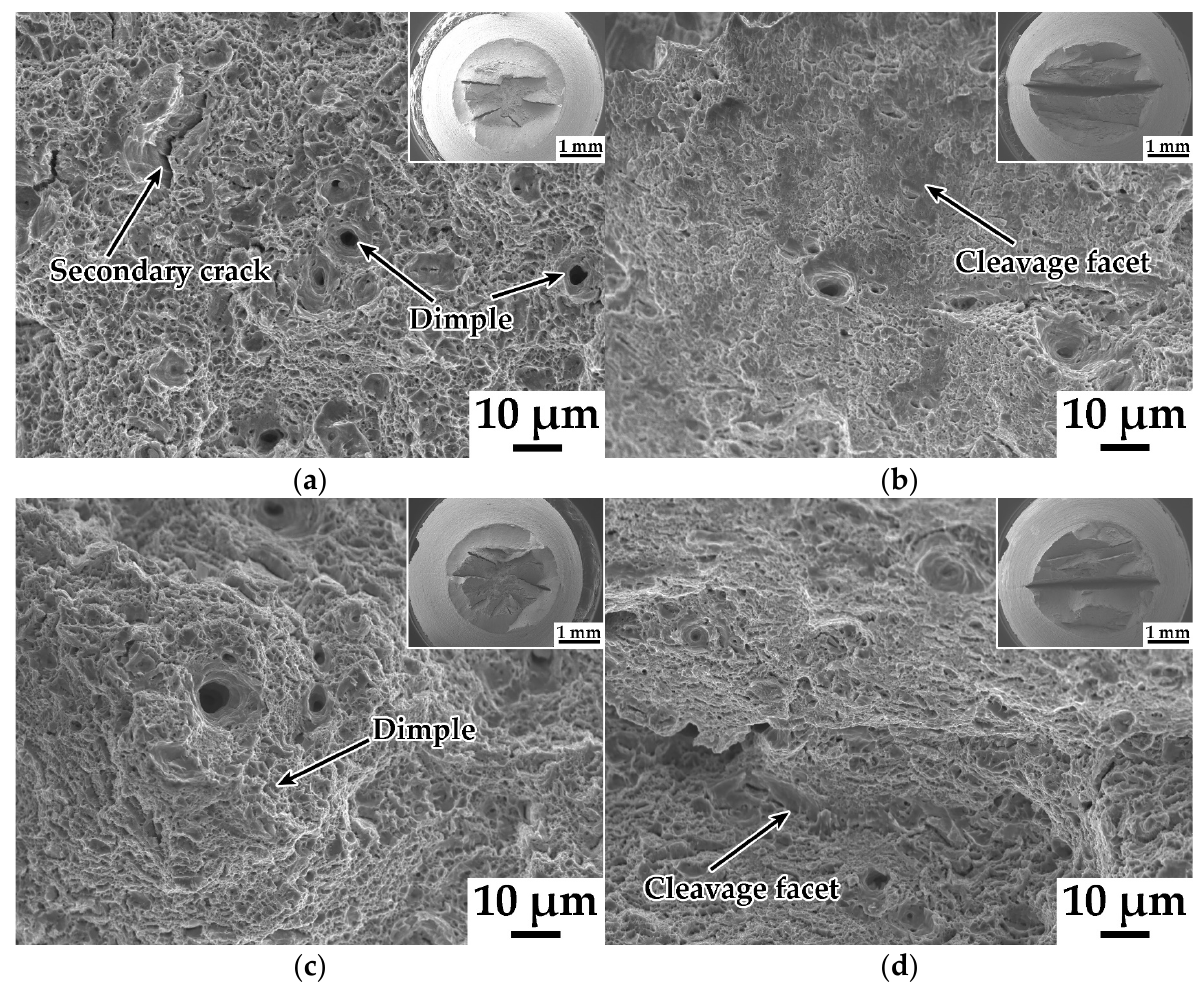
Figure 11. The fracture surface after the tensile test at the bending axis and unbent zones: fiber zones of the ( a ) unbent areas, ( b ) outer arc, ( c ) mid-thickness, and ( d ) inner arc.